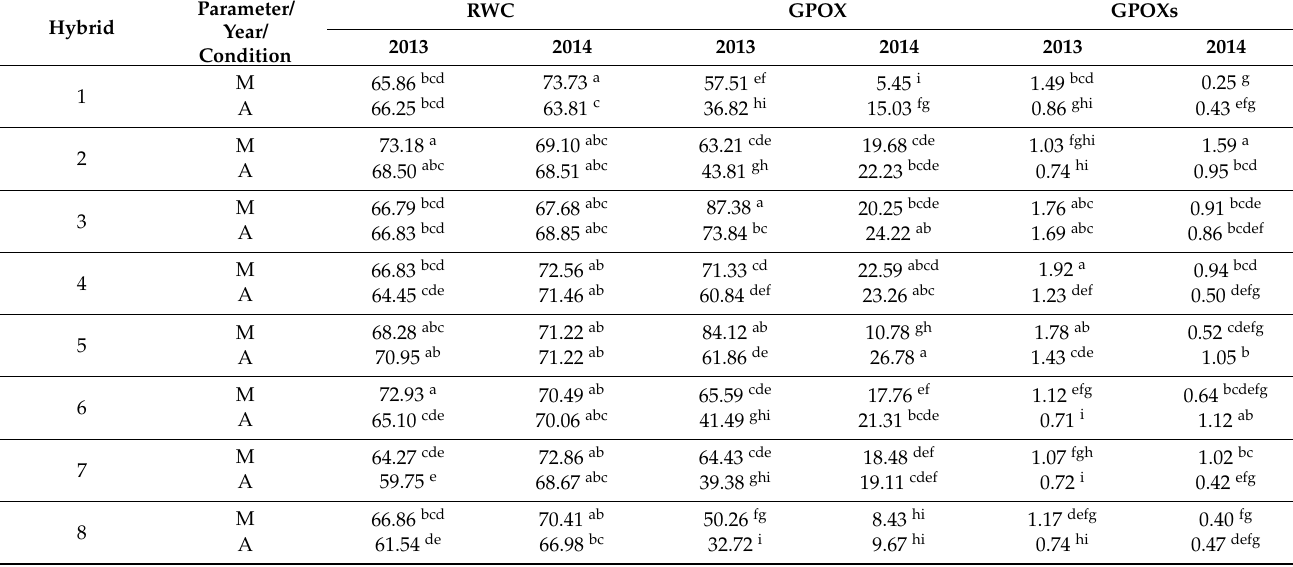
Table 2. Mean values of the physiological and biochemical parameters ( n = 20) for eight sunflower hybrids in the morning and afternoon conditions in 2013 and 2014. Means with the same letters in columns are not significantly different according to Tukey’s HSD 0.01